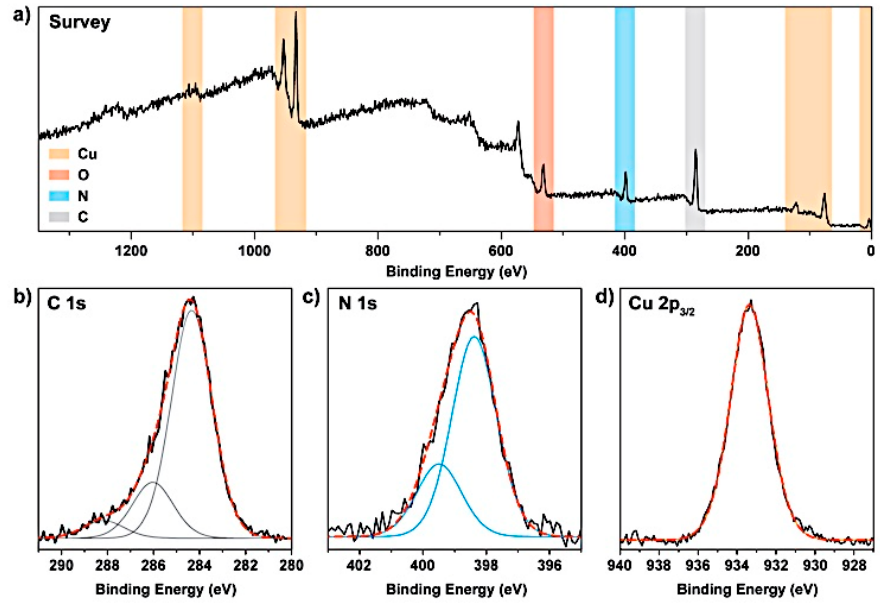
Figure 1. ( a ) XPS survey spectrum, ( b ) C1s, ( c ) N1s, and ( d ) Cu 2p 3/2 XPS spectra of the Cu/gCN material produced by laser ablation under acetonitrile.